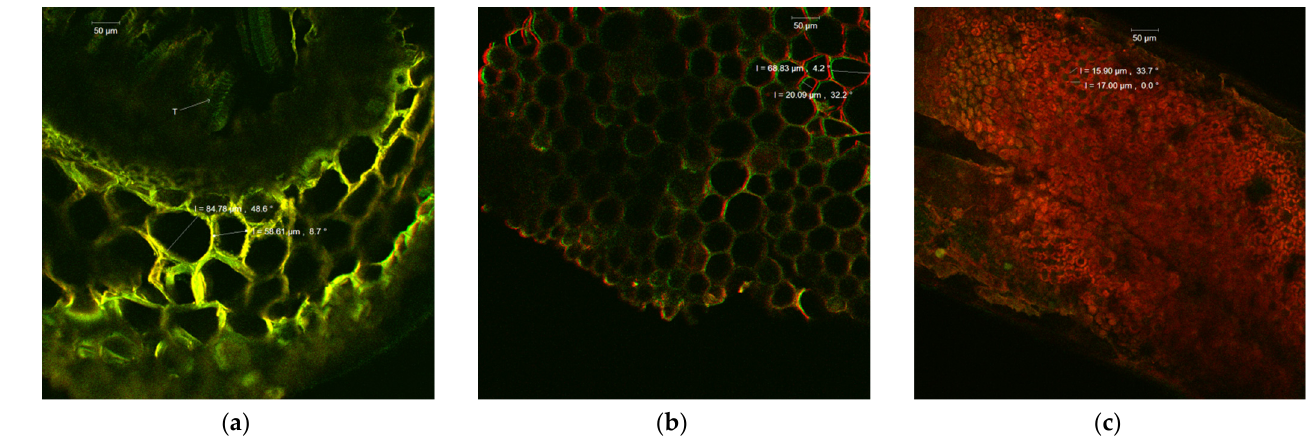
Figure 1. Sections of ( a , b ) stem and ( c ) leaves of A. foeniculum AdB observed using CLSM.